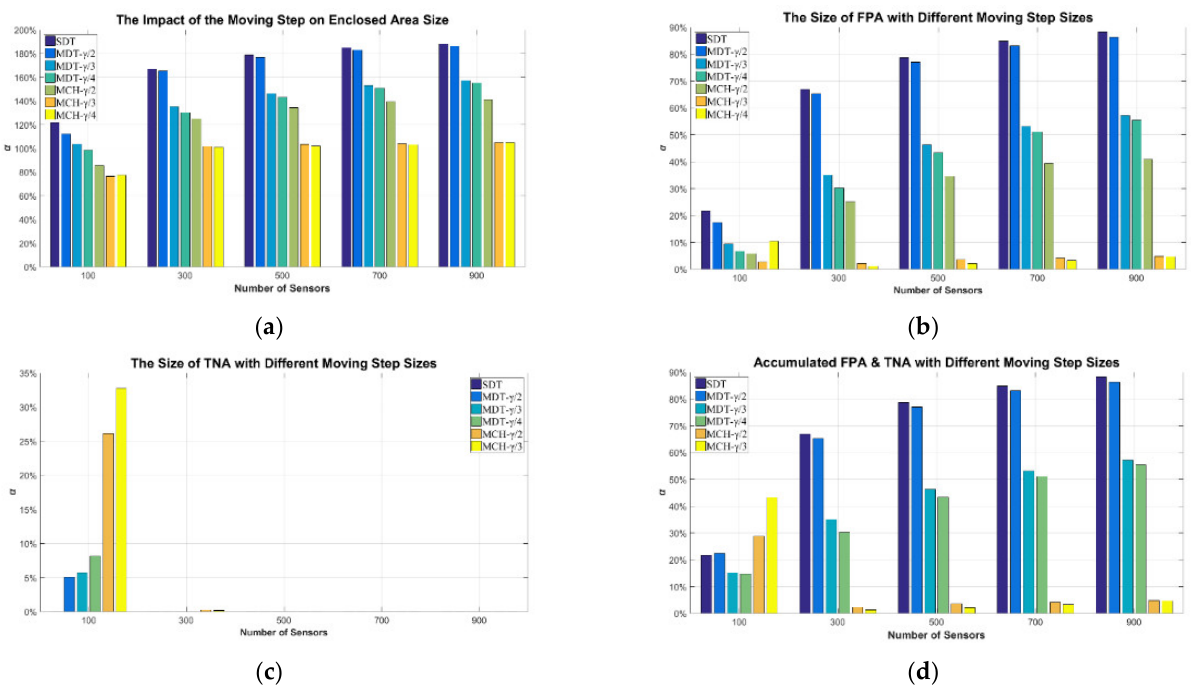
Figure 6. The Impact of Moving Step Sizes on the Enclosed Area ( a ) The ratio α of the enclosed area sizes. The value of α is the ratio of the area enclosed by an evaluated method over the practice size of the continuous object. An algorithm is said to have high precision if α is close to 100%. ( b ) The ratio α of the FPA in the enclosed area. ( c ) The ratio α of the TNA in the enclosed area. ( d ) The ratio α of the accumulated FPA and TNA in the enclosed